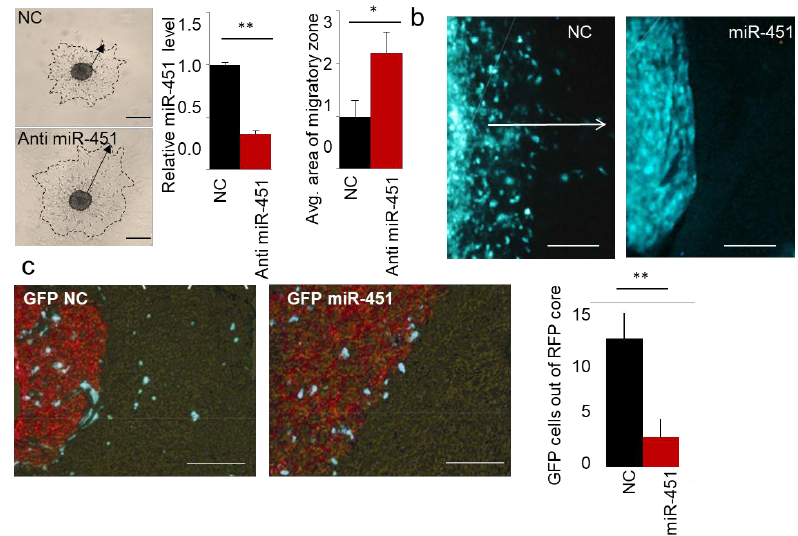
Figure 1. miR-451 impedes migration of GBM cells in vitro and invasiveness of GSCs in vivo. ( a ) Representative images of spheroid migration, qRT-PCR of miR-451 upon anti-miR-451 transfection, and quantification. ( b ) Representative images of intracranial xenografts of GBM12 cells expressing control GFP or GFP miR-451. White arrow depicts invasive zone. ( c ) Representative images of intracranial xenografts of GBM12 cells expressing control GFP or GFP miR-451 admixed with Red Fluorescent Protein-labeled Gli36 cells ( left ), quantification of GFP cells outside RFP core per random field ( right ). * p -value < 0.05, ** p -value <